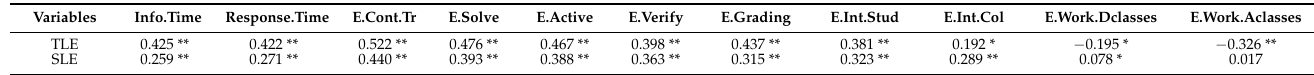
Table 14. Correlations between teachers’ and students’ level of online teaching enthusiasm and other